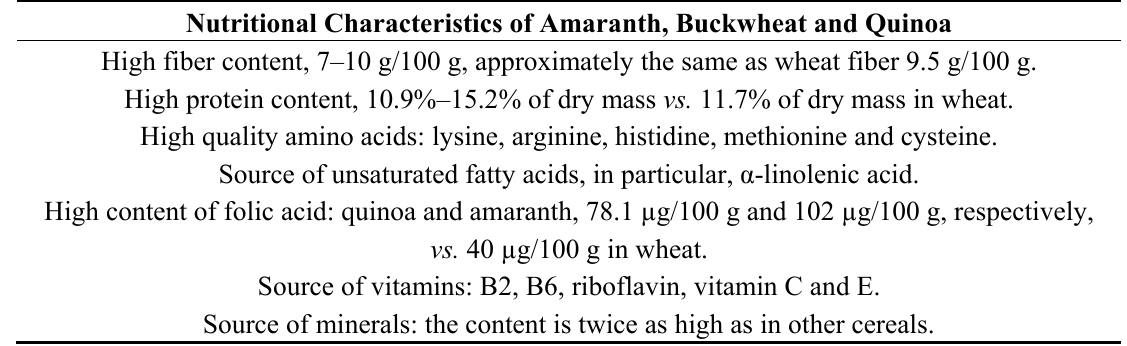
Table 3. Nutritional advantages of pseudo-cereals (amaranth, buckwheat and quinoa). Nutritional Characteristics of Amaranth, Buckwheat and Quinoa High fiber content, 7–10 g/100 g, approximately the same as wheat fiber 9.5 g/100 g. High protein content, 10.9%–15.2% of dry mass vs. 11.7% of dry mass in wheat. High quality amino acids: lysine, arginine, histidine, methionine and cysteine. Source of unsaturated fatty acids, in particular, α -linolenic acid. High content of folic acid: quinoa and amaranth, 78.1 µg/100 g and 102 µg/100 g, respectively, vs. 40 µg/100 g in wheat. Source of vitamins: B2, B6, riboflavin, vitamin C and E. Source of minerals: the content is twice as high as in other